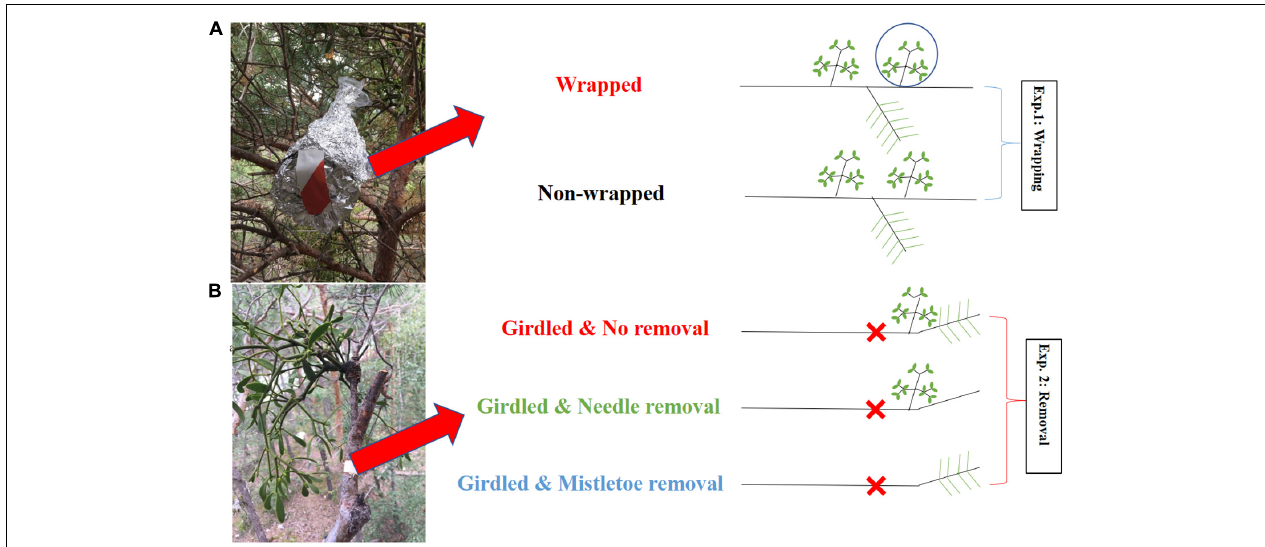
FIGURE 1 | Scheme of the wrapping experiment [ (A) : Exp. 1] and the girdling and removal experiment [ (B) : Exp. 2], with drawings showing the treatments applied to mistletoes and pine twigs on the right-hand site. In Exp. 1, mistletoe clusters were covered with gas-tight plastic sheets and aluminum foil to prevent direct 13 C label uptake during the whole-tree 13 CO 2 labeling experiment; non-wrapped controls were allowed to take up 13 CO 2 . In Exp. 2, the bark including phloem was girdled for three branches per tree before the whole-tree labeling to create an isolated environment without top-down carbon transportation via the host’s phloem, and each of these three branches was randomly assigned to mistletoe removal, pine needle removal, or intact control.